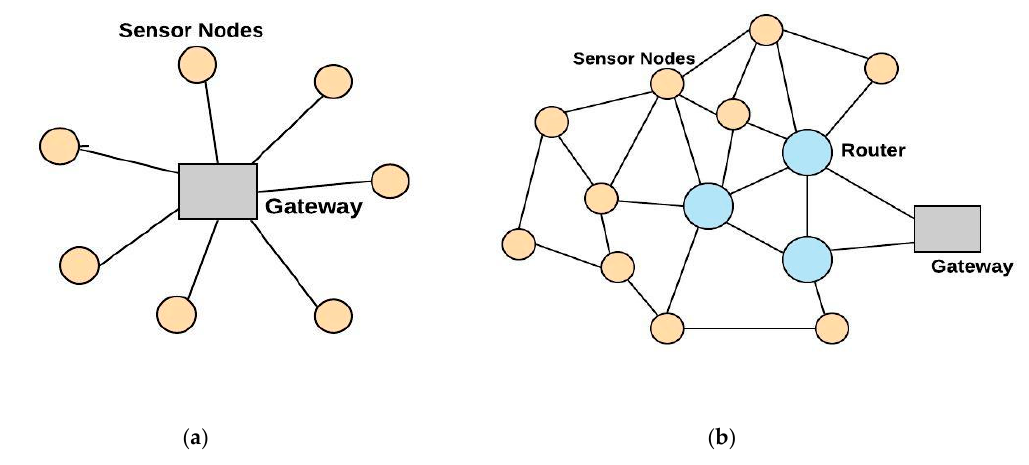
Figure 3. ( a ) Star topology, ( b ) mesh network topology.